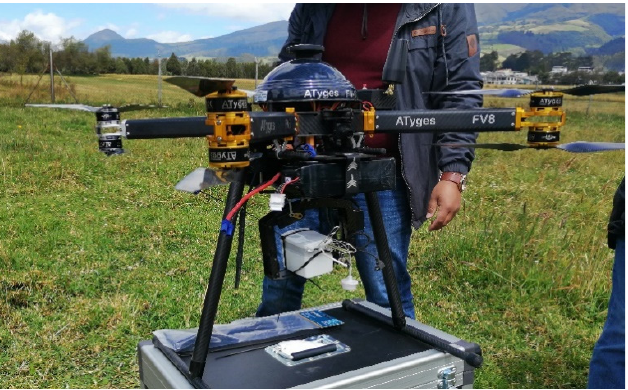
Figure 2. Vaisala RS92-SGP sensor tethered to the ATyges FV8 drone used in this